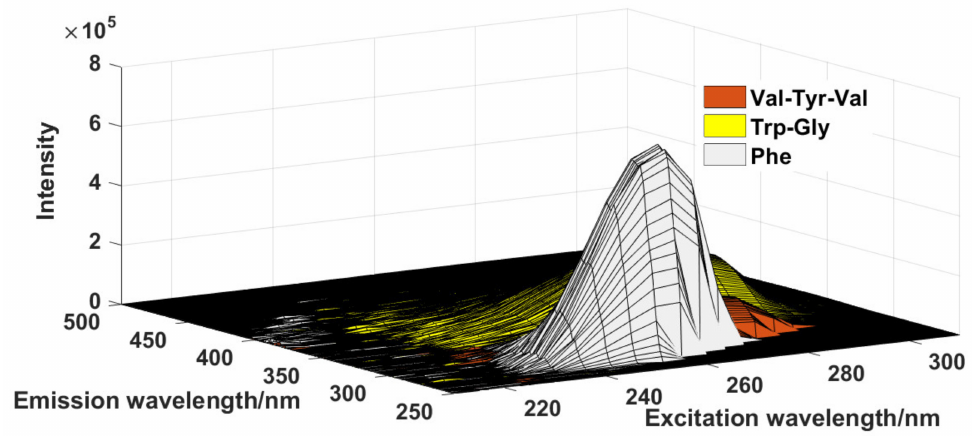
Figure 1. The EEM spectra for each target compound in Data Set